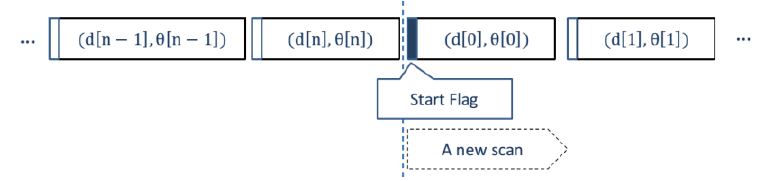
Figure 4. Data frames from the RPLIDAR A1M8.